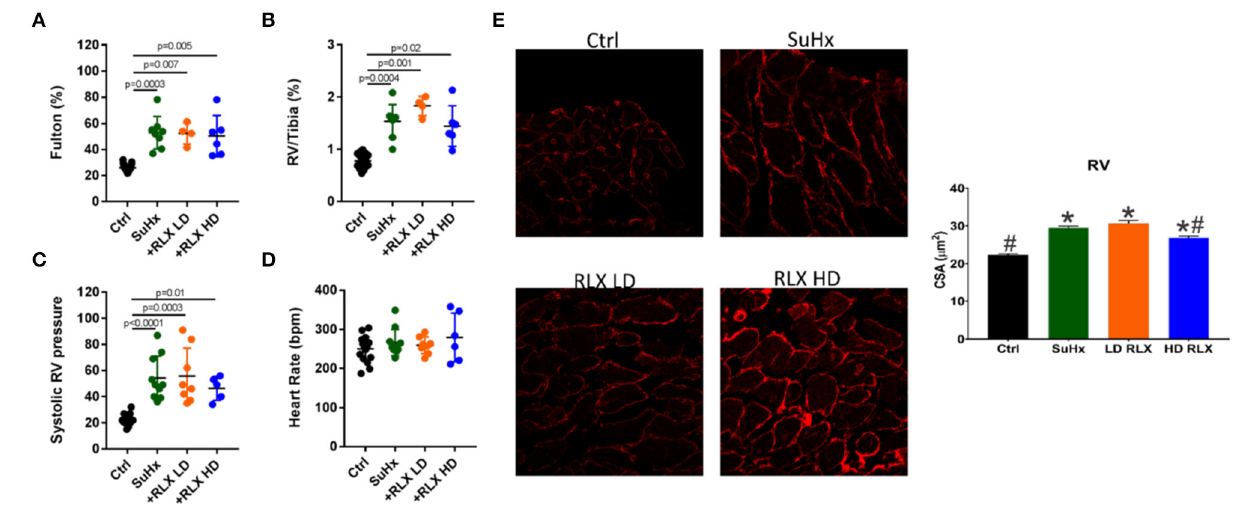
FIGURE 1 | Effects of RLX on RV hypertrophy and pulmonary pressure in PAH. Sugen/Hypoxia significantly increased RV hypertrophy as measured by (A) Fulton Index and (B) RV/Tibia ratio. Low ( + RLX-LD) and high ( + RLX-HD) had no effect on RV hypertrophy. (C) Sugen/Hypoxia significantly increased systolic pressure and Relaxin failed to alter it. (D) Heart rate did not significantly change in all four groups. (E) SuHx hearts had a small but significant increase in myocyte cross-sectional area (CSA) (WGA-label) which was prevented by RLX-HD but not RLX-LD; n > 100 cells/group. *Indicates p < 0.05 vs. control. # Indicates p < 0.05 vs.